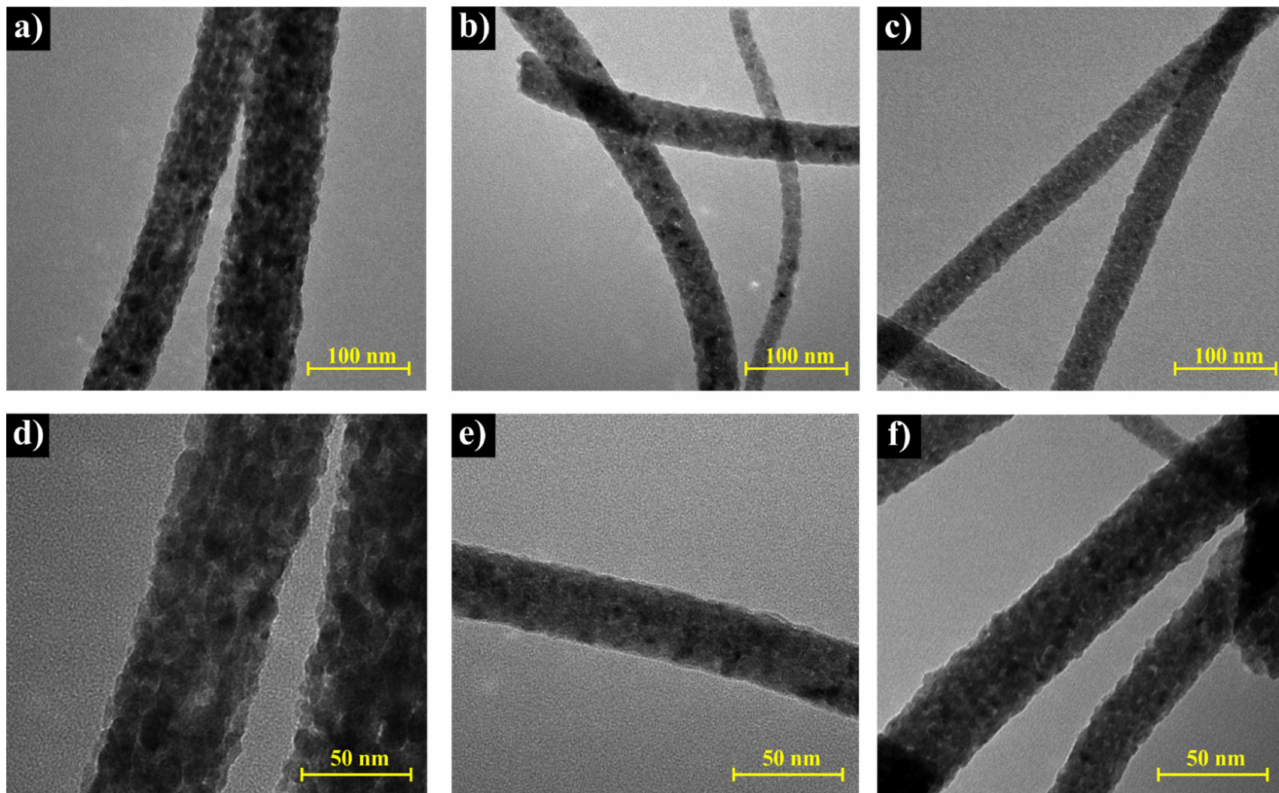
Figure 4. Smaller (scale 100 nm) and larger magnification (scale 50 nm) TEM images of Ag–TiO 2 nanostructured nanofibers: pure TiO 2 ( a ), 0.1% Ag–TiO 2 ( b ), 5.0% Ag–TiO 2 ( c ), TiO 2 ( d ), 0.1% Ag–TiO 2 ( e ), and 5.0% Ag–TiO 2 ( f ).